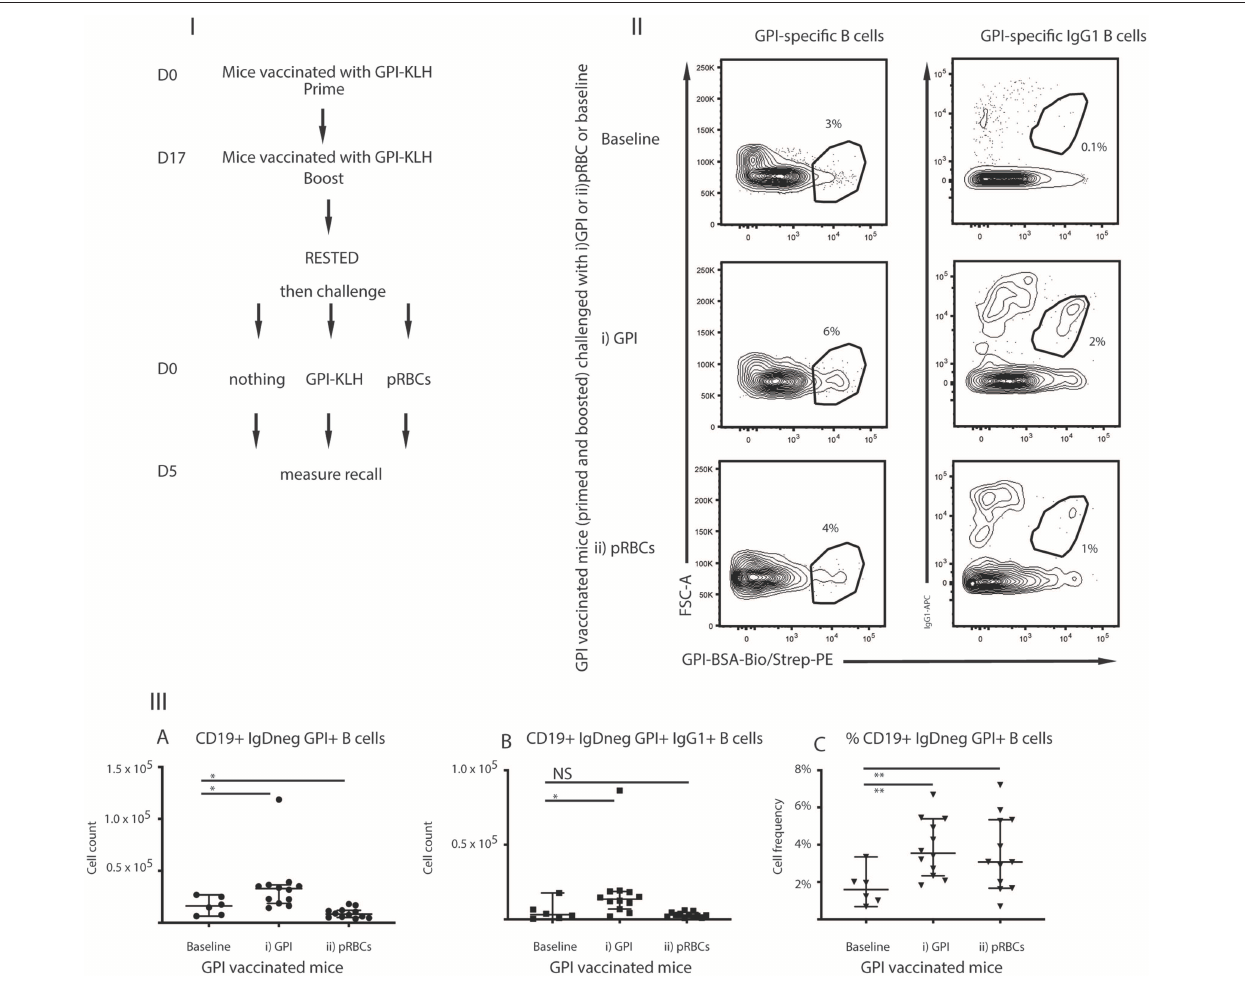
FIGURE 3 | Challenge with (i) synthetic GPI-KLH or (ii) pRBCs induced rapid recall/activation of GPI-specific MBCs in previously GPI-vaccinated mice compared to baseline memory mice. Panel (I) Mice were vaccinated and boosted with GPI-KLH ( n = 30). After resting for a minimum of 10 weeks when the B cells are considered to be in the quiescent memory phase, mice were injected with (i) GPI-KLH i.p. ( n = 12) or (ii) 1 × 10 5 pRBCs i.p. ( n = 12) or nothing (baseline; n = 6) to assess reactivation of MBCs. Panel (II) outlines FACS plots. Panel (III) is the analysis of B cell populations for the number of cells per spleen for (A) GPI-specific B cells, (B) GPI-specific IgG1 B cells, and (C) calculated cell frequencies of GPI-specific B cells as a proportion of all activated B cells. Experiments were reproduced independently thrice. Pooled data from all mice from all 3 experiments are represented as median ± 95%-CI. Data was analyzed using the non-parametric Mann-Whitney test and significance was determined at P < 0.05. * P < 0.05, ** P < 0.01, NS not